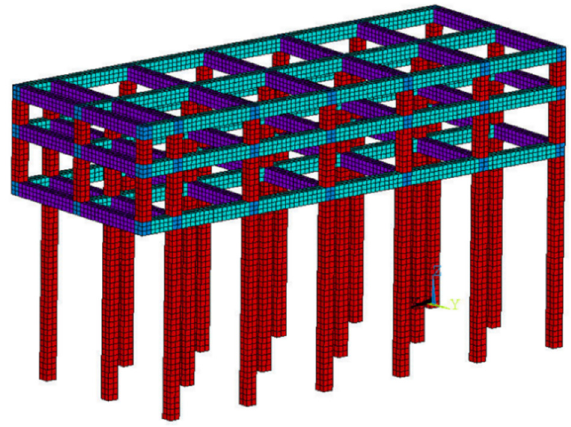
Figure 1. Finite element model of wharf frame structure.